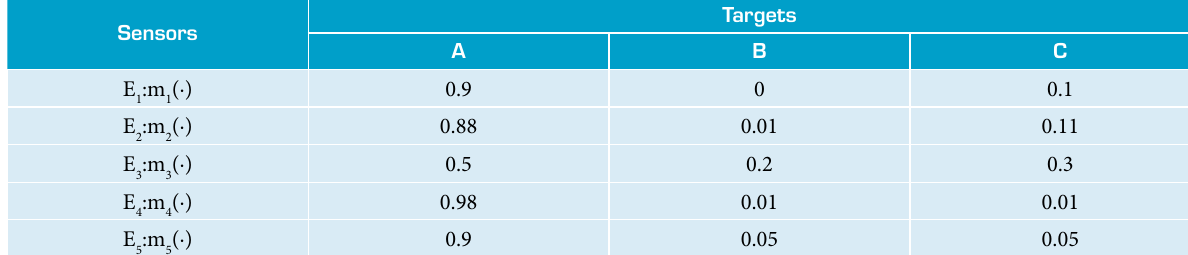
Table 1. Mass assignments of low conflicting information.